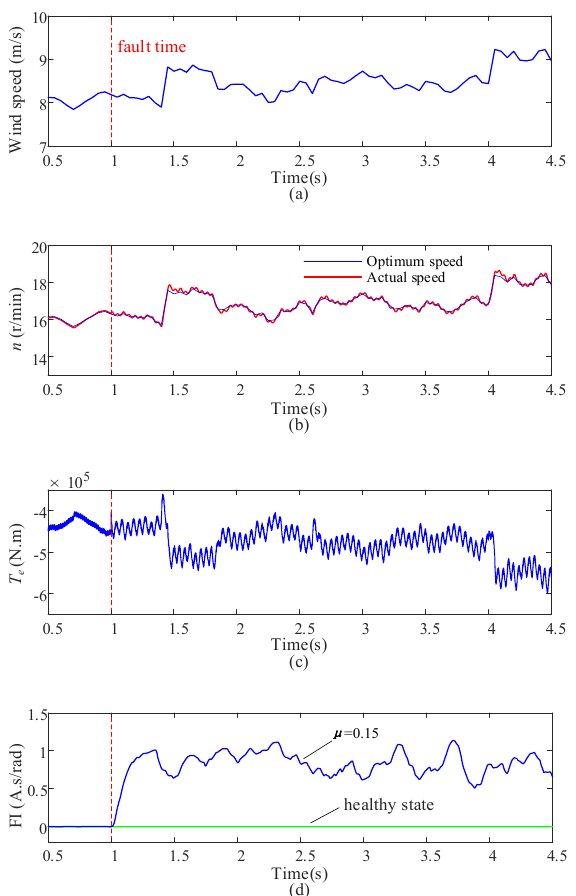
Figure 13. Fault detection results at random wind speed. ( a ) Random wind speed; ( b ) optimum and actual speeds of PMSG; ( c ) electromagnetic torque; ( d ) fault detection index.